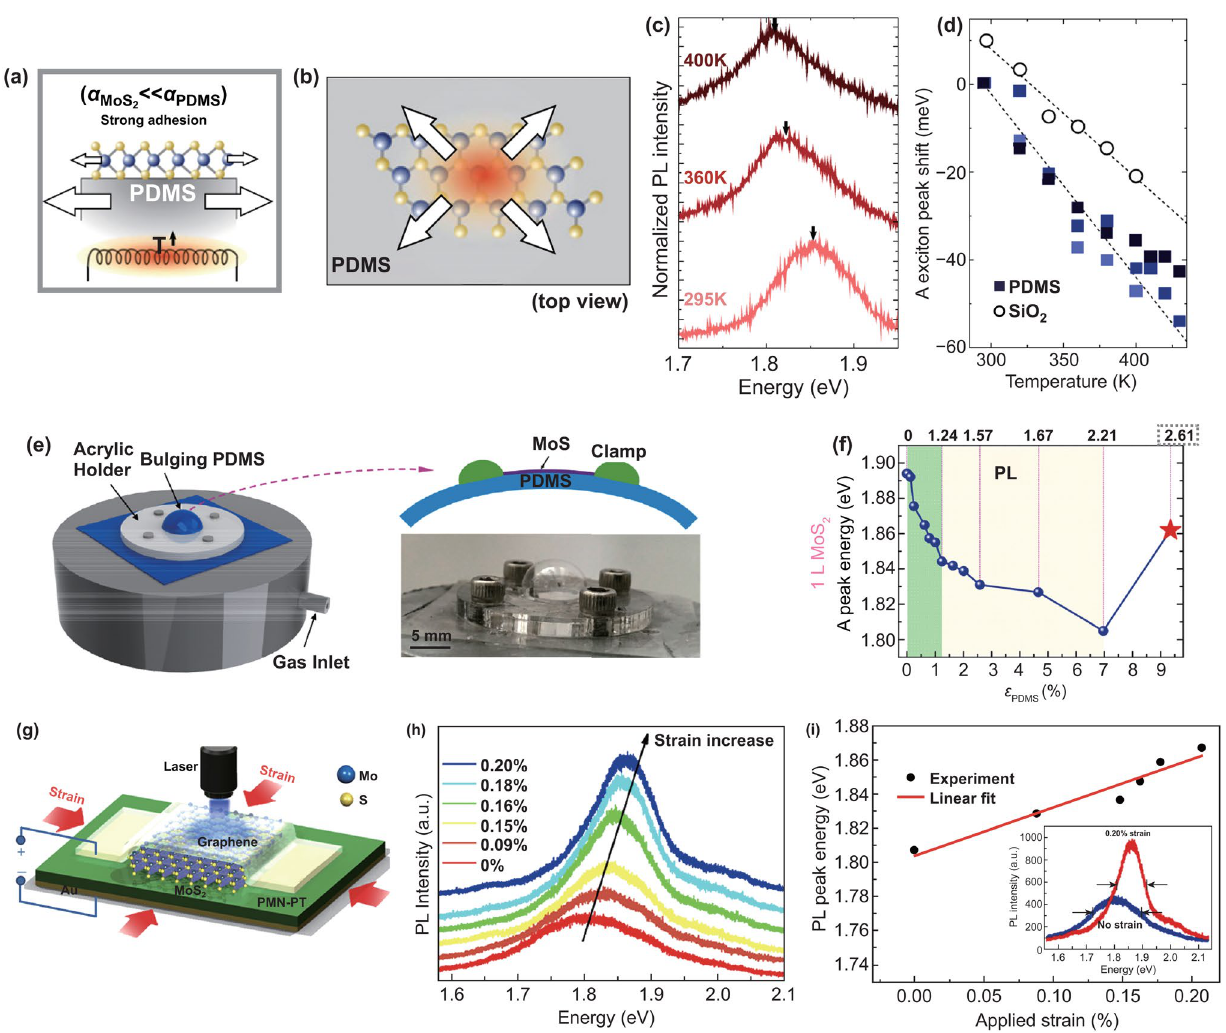
Fig. 8 Applied biaxial strain to 2D semiconductors. a Schematic of applied biaxial strain on MoS 2 through heating PDMS substrate. b Top view of a monolayer MoS 2 on PDMS substrate. c Temperature-dependent PL spectra of MoS 2 on PDMS substrate. d Temperature-dependent shift of the A exciton peak position on PDMS and SiO 2 substrates. Reproduced with permission [145]. Copyright 2015, IOP Publishing. e Measurement setup of blown-bubble bulge technique. f Extracted PL peak position shift with applied strain in PDMS. Reproduced with permission [146]. Copyright 2017, American Chemical Society. g Schematic of applied biaxial compressive strain to 2D MoS 2 . Effect of biaxial compressive strain on the PL spectra h and PL peak energy i of the MoS 2 . Reproduced with permission [148]. Copyright 2013, American Chemical